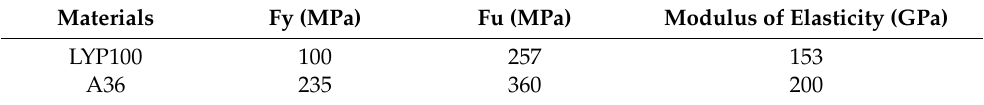
Table 1. Material properties [30].